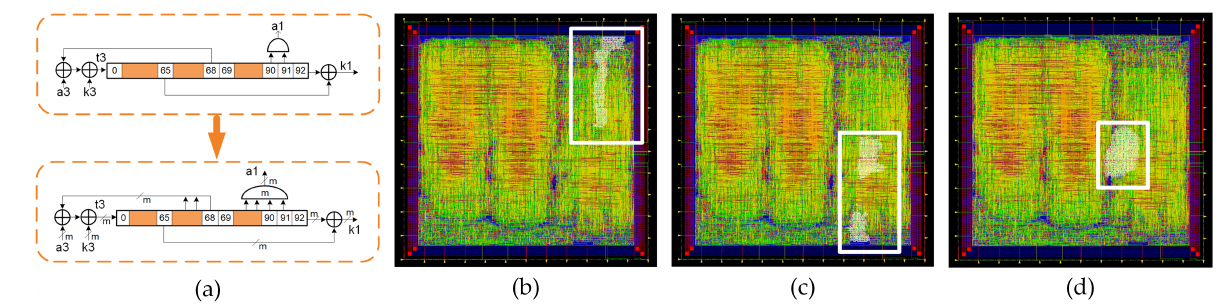
Figure 3. ( a ) Schematic representation of the first register for the standard cipher and multi-radix cipher (top and bottom, respectively). ( b ) Layout of the ASIC highlighting the location of the multi-radix × 2 layout, ( c ) multi-radix × 8 layout and ( d ) multi-radix × 16 layout.